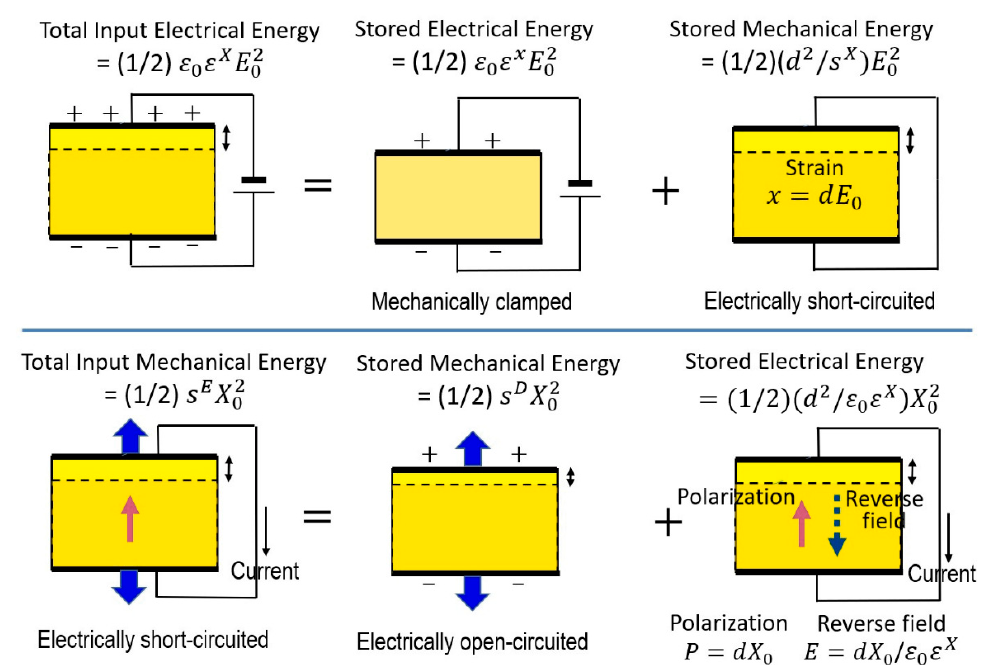
Figure 5. Schematic representation of the response of a piezoelectric material under: Top constant applied electric field and Bottom constant applied stress conditions.